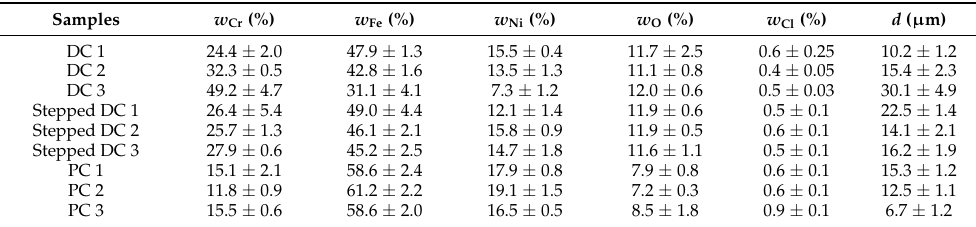
Table 3. Composition (mass fractions w ) and layer thickness d of the as-deposited layers. Samples